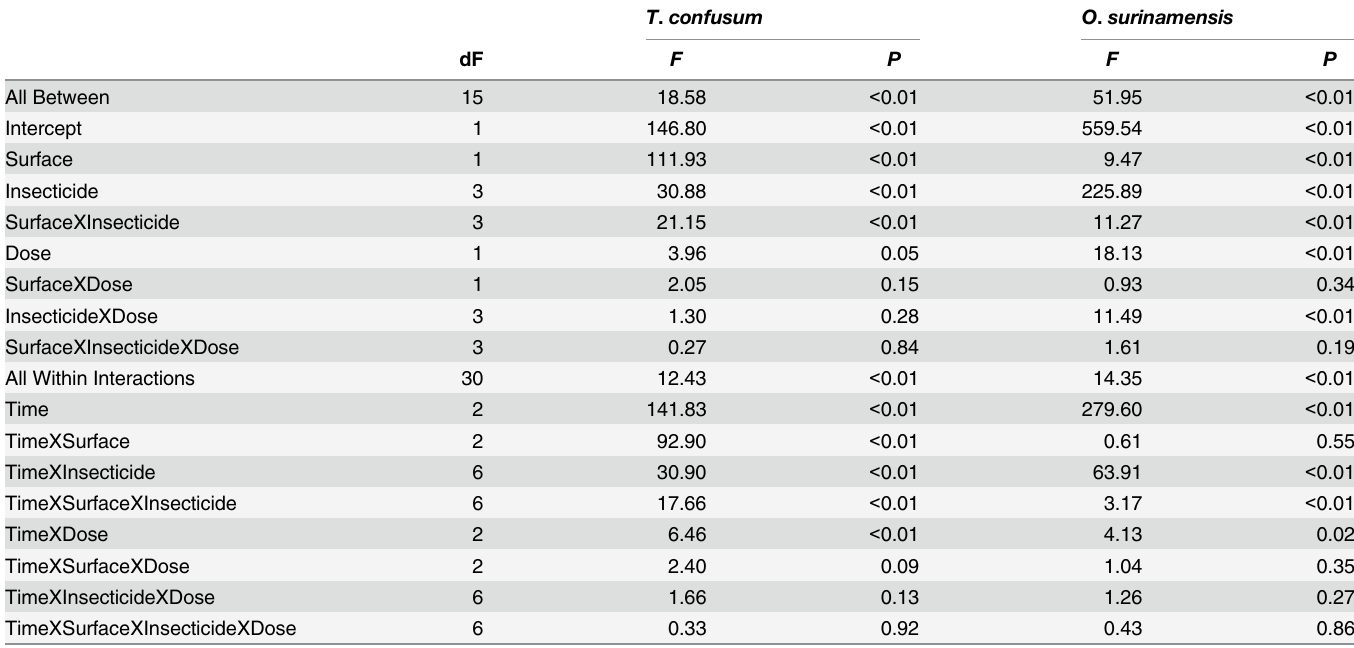
Table 1. Repeated-measures ANOVA parameters for T . confusum and O . surinamensis adult